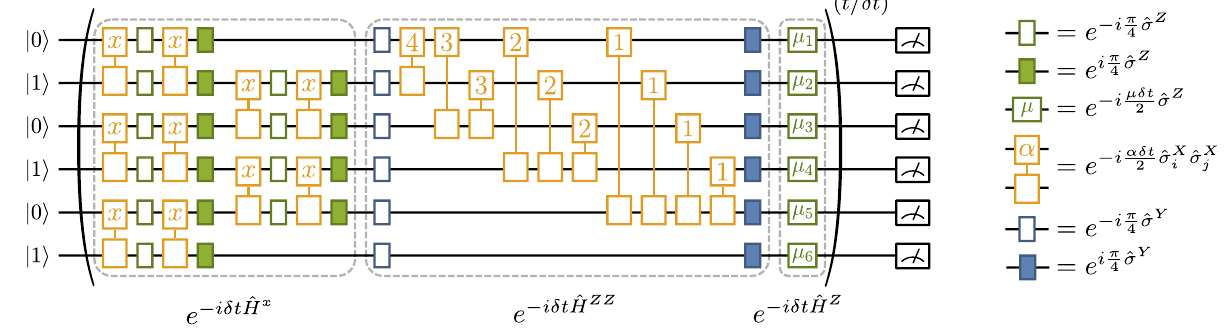
FIG. 4. The circuit for the Trotterized evolution according to the Hamiltonian in Eq. (2) for N = 6 lattice sites, with odd-even ordering of the Trotter decomposition introduced in Eq. (11). The interaction term e − i δ t ˆ H x is implemented with nearest-neighbor X i X i + 1 and Y i Y i + 1 gates. The e − i δ t ˆ H ZZ term is implemented with X i X j and R i rotations. The e − i δ t ˆ H Z term involves only Z i rotations, with the angles μ 1 = − (μ + 3 )δ t , μ 2 = (μ − 2 )δ t , μ 3 = − (μ + 2 )δ t , μ 4 = (μ − 1 )δ t , μ 5 = − (μ + 1 )δ t , and μ 6 = μδ t . Qubits are initialized in the bare-vacuum state | 010101 (cid:2) , then evolved by repeating the circuit in the parentheses t /δ t times, and measured individually in the Z basis at the